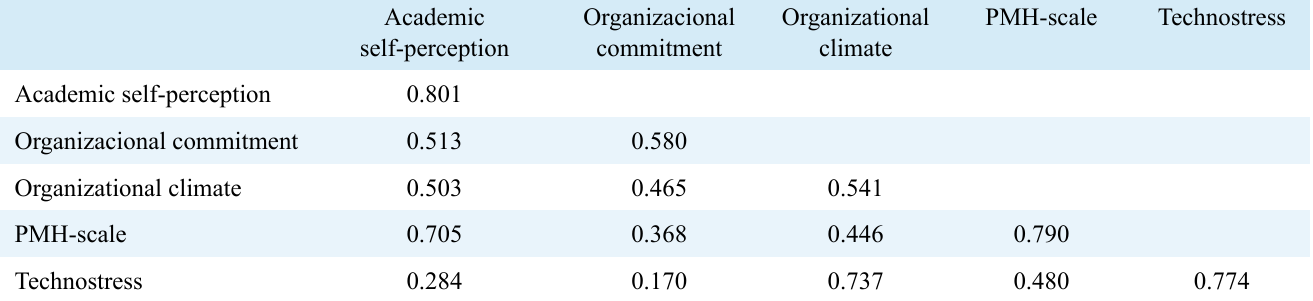
TABLE 3. Discriminant validity.